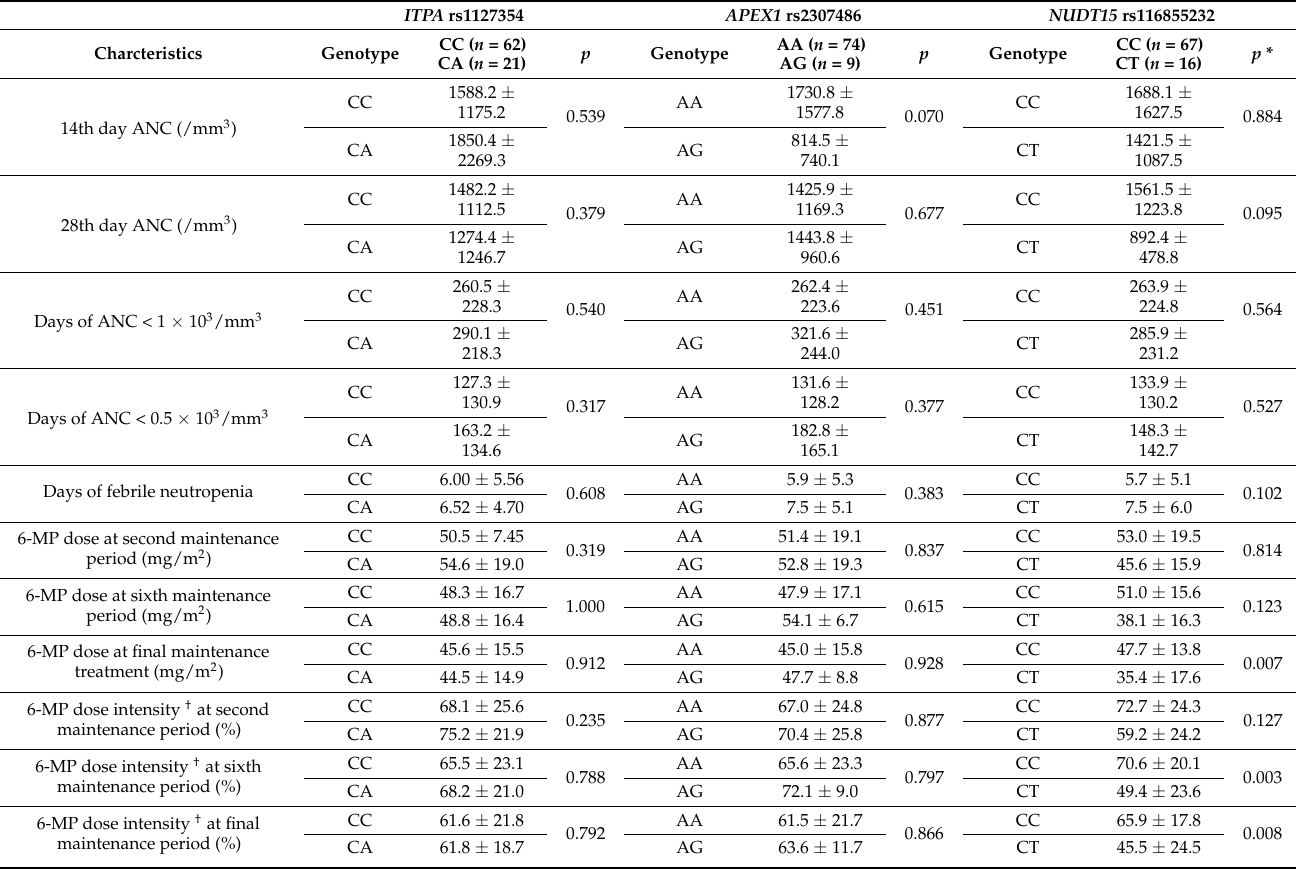
Table 2. Relationships between genotypes of candidate genes and parameters for 6-MP-related toxicities and